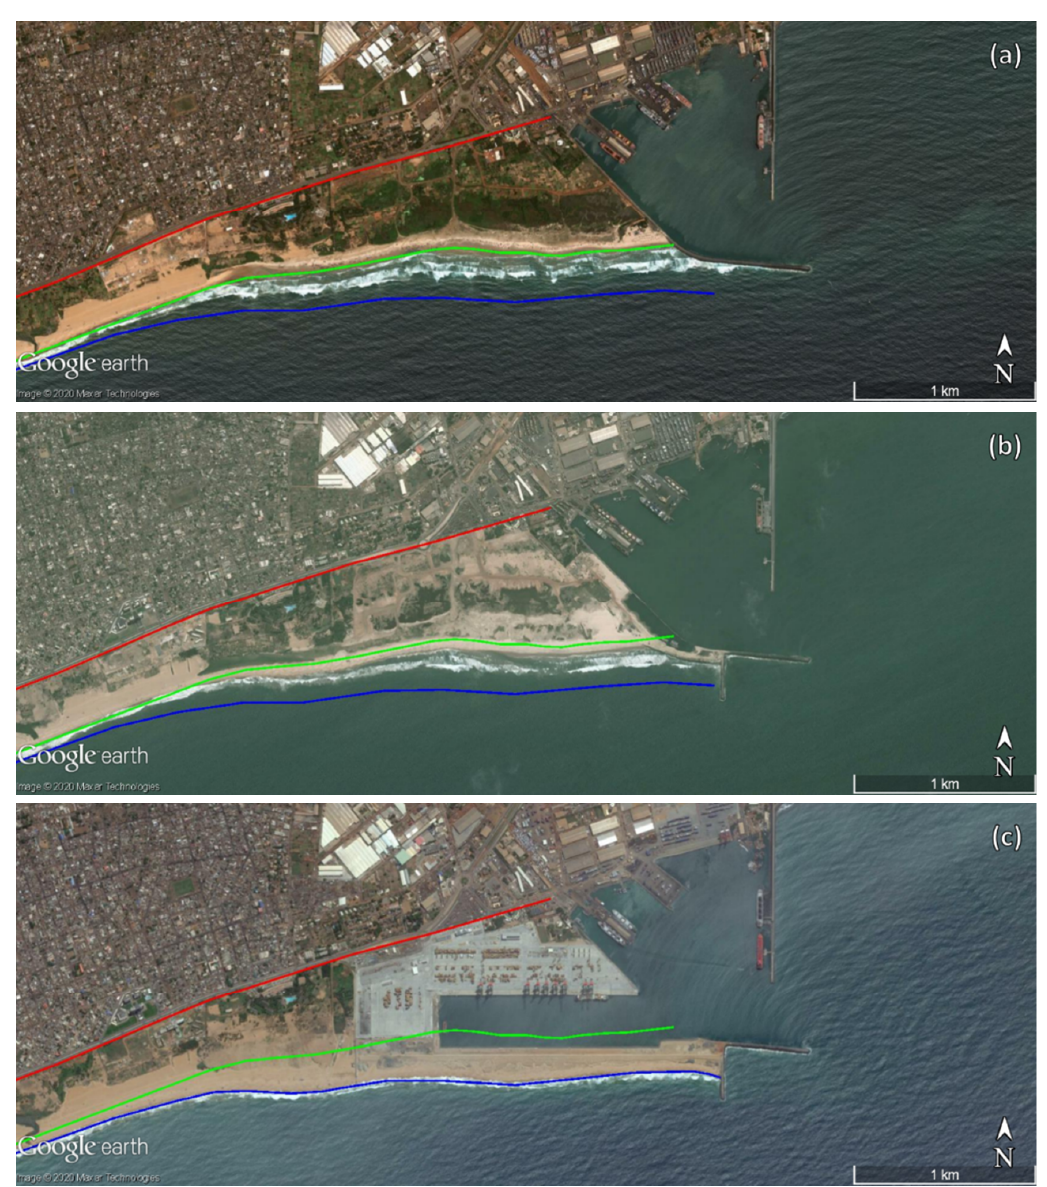
Figure 4. ( a ) Satellite image from 26 August 2009 from [15]. Red line: indicative coastline before start of construction of the breakwater around 1967 (based on figures in [14]), green line: coastline at moment of satellite image, blue line: coastline at moment of satellite image on 18 May 2016, ( b ) satellite image from 18 May 2012 from [15]. An additional spur has been constructed to prevent heavy bypassing and consequent siltation of the approach channel. ( c ) Satellite image: from 18 May 2016 from [15]. The accreted area is used for the port expansion and naturally a sandbar is created that forms the basis for the port protection.